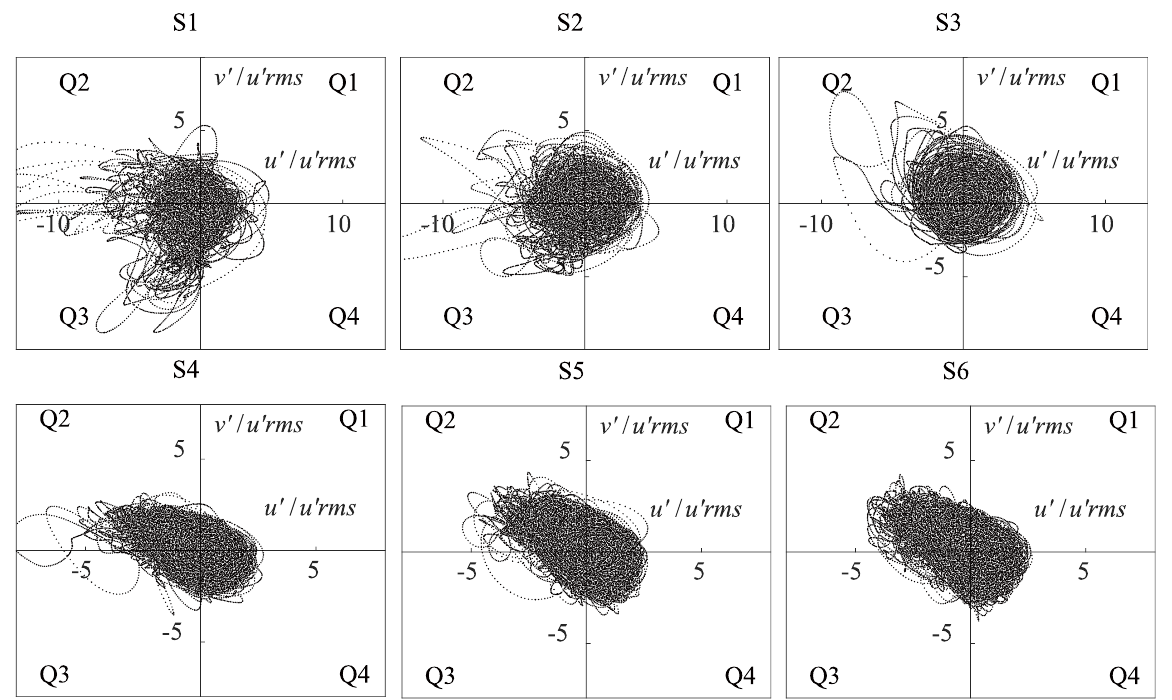
Figure 12. Quadrant analysis of the streamwise and spanwise velocity fluctuations normalized by u’ rms for Case 2 at z / H = 0.93; Q1–Q4 represent the four quadrants, respectively.